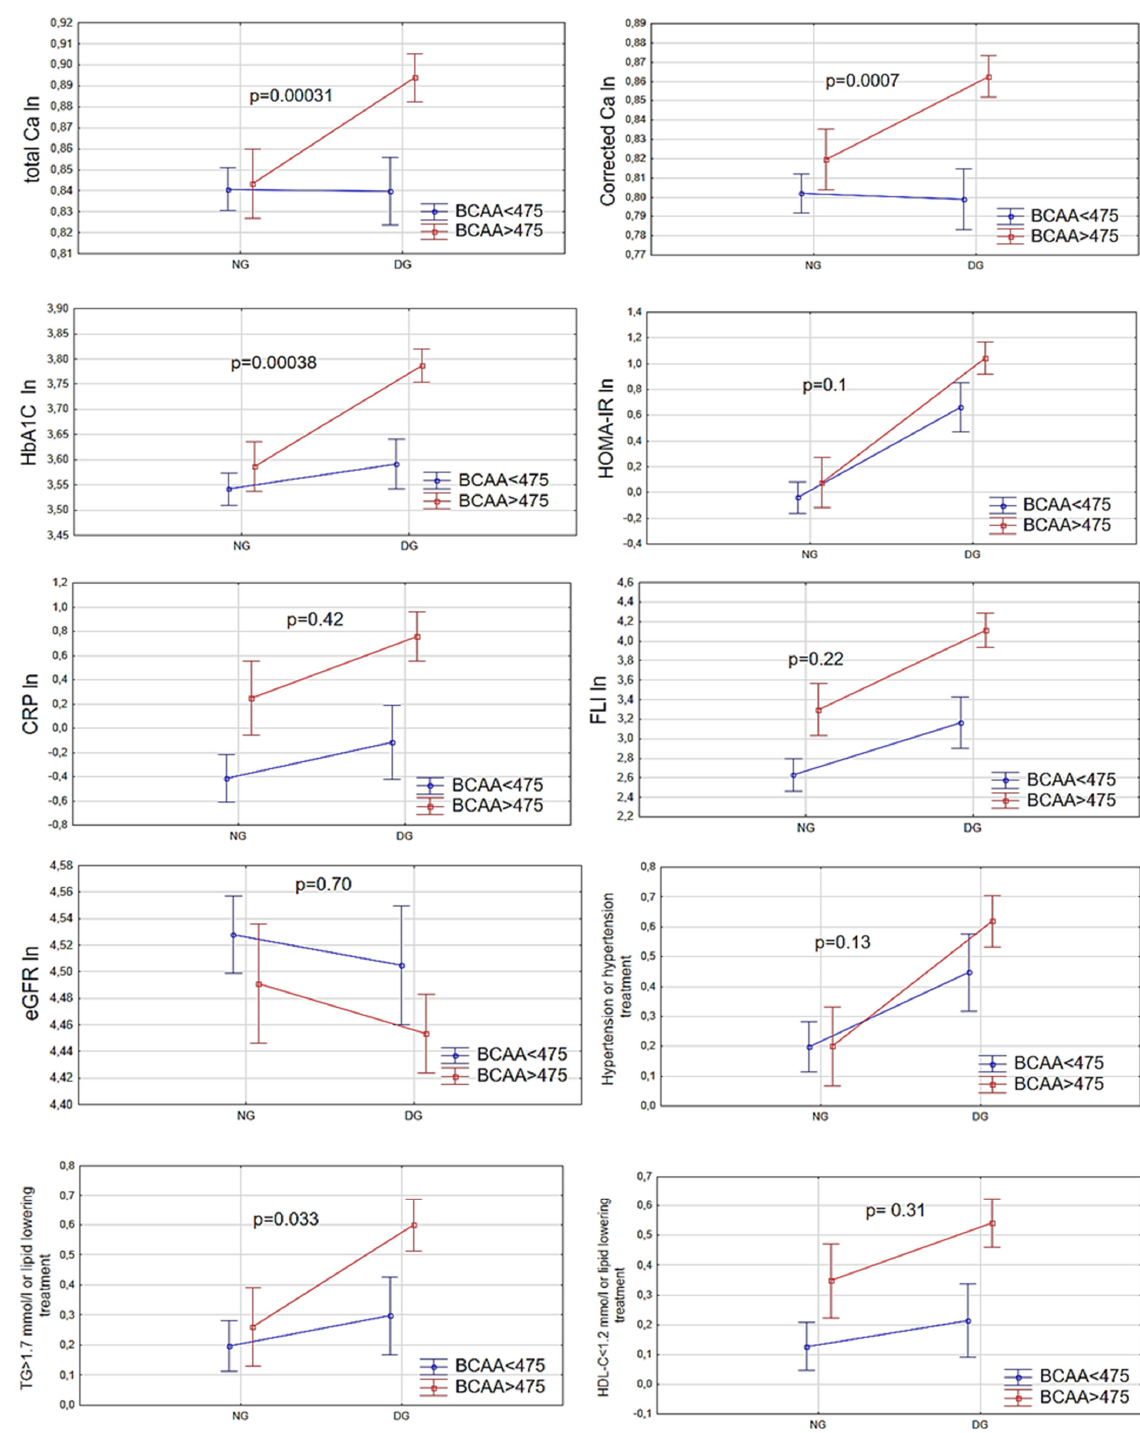
Figure 1. Results of cardiometabolic risk factors in relation to glycemic status (NG, DG) and BCAA concentrations above or below their median (475 μ mol/L) in the women. Two-way ANOVA; the glycemic status and BCAA subgroups as the qualitative factors, and total Ca, corrected Ca, HbA1c, HOMA-IR, CRP, FLI, eGFR, hypertension or hypertension therapy, and dyslipidemia (HDL < 1.2 mmol/L, TG > 1.7 mmol/L or lipid-lowering treatment) as dependent variables. NG—normoglycemic group, DG—dysglycemic